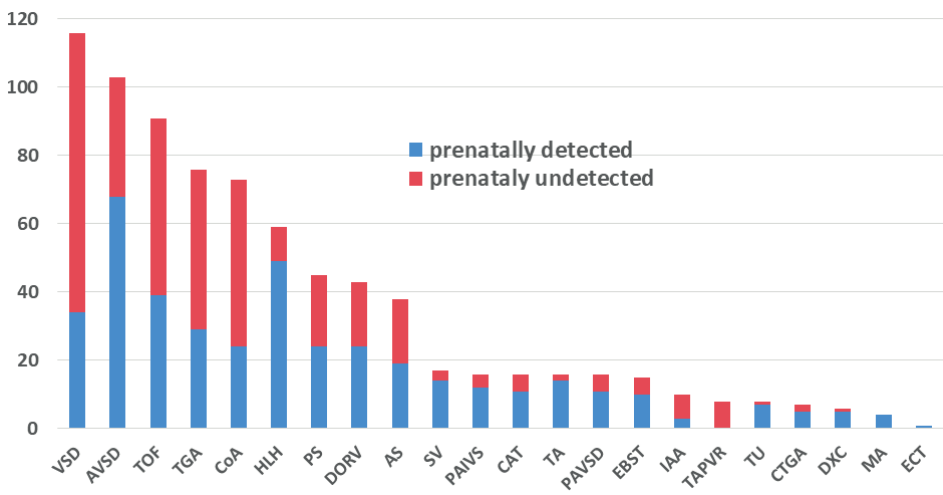
Fig. 1. CHD incidence (n=819) and proportion detected prenatally. (VSD-ventricular septal defect, AVSD-atrioventricular septal defect, TOF-tetralogy of Fallot, TGA-transposition of great arteries, CoA- coarctation of aorta, HLH-hypoplastic left heart syndrome, PS-pulmonary stenosis, DORV- double outlet right ventricle, AS-aortic stenosis, SV-single ventricle, PAIVS- pulmonary atresia/ intact ventricular septum, CAT- common arterial trunk, TA- tricuspid atresia, PAVSD- pulmonary atresia/ventricular septal defect, EBST- Ebstein’s anomaly, IAA- interruption of the aortic arch, TAPVR- total anomaly of pulmonary venous return, TU-tumor, CTGA- corrected transposition of great arteries, DXC-dextrocardia, MA-mitral atresia, ECT-ectopia